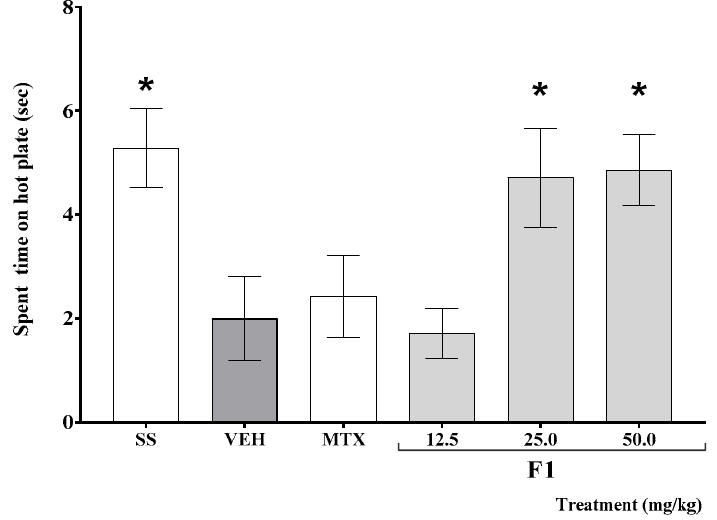
Figure 1. Effect of the F1 fraction of A. angustifolia extract at different doses on the AUC of the time course plot of joint inflammation in a murine model of K/C-induced mono-arthritis. The plots show